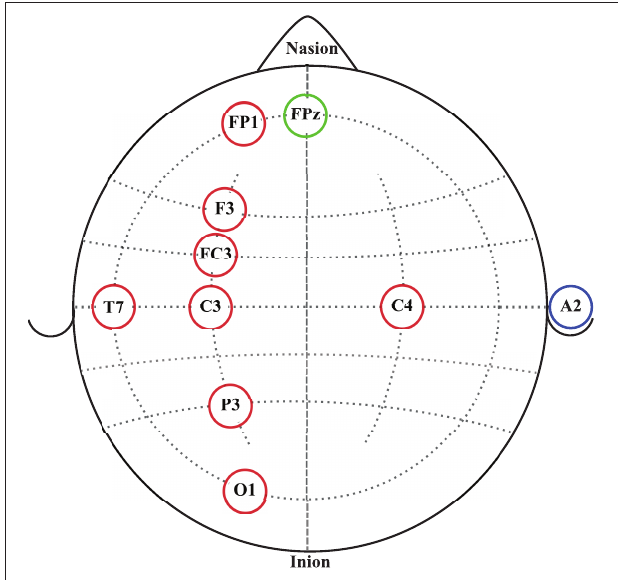
FIGURE 2 | EEG electrode placement according to the International 10-10 system of electrode placement. Red circles represent the eight active electrodes selected for the data acquisition. The blue circle represents the reference electrode location. The green circle represents the ground electrode